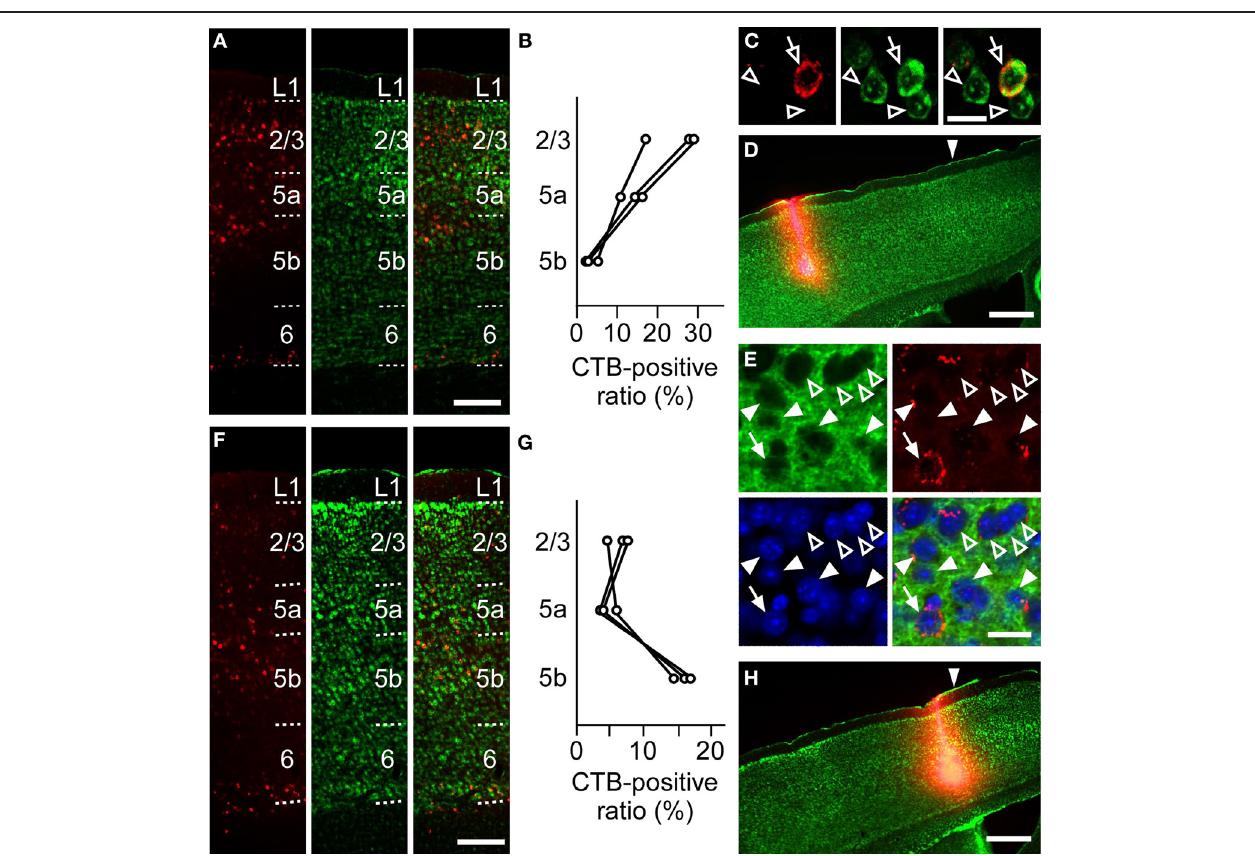
Nissl staining (blue), and the overlay in the L5b CFA after CTB-Alexa 594 injection into the RFA of a ChR2 Tg mouse. Closed arrows indicate a ChR2-EYFP-positive and CTB-positive neurons. Closed arrowheads indicate ChR2-EYFP-positive and CTB-negative neurons. Open arrowheads indicate ChR2-EYFP-negative and CTB-negative neurons. Scale bar, 20 µ m. (F) Anti-CTB immunofluorescence (left), Nissl staining (middle), and the overlay (right) in the RFA after CTB-Alexa 594 injection into the CFA in (H) . Scale bar, 200 µ m. (G) Ratios of CTB-positive neurons to Nissl-stained neurons in L2/3, L5a, and L5b of the RFA after CTB-Alexa 594 injection into the CFA. Each line indicates one mouse. (H) Anti-CTB immunofluorescence and Nissl staining of the CFA are overlaid. Arrowhead indicates 0mm anterior and 1.0mm lateral from the bregma. Scale bar, 500 µ